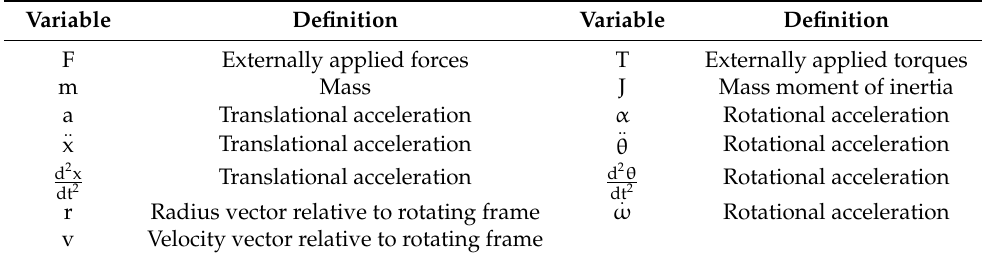
Table 2. Proximal variable definitions 1